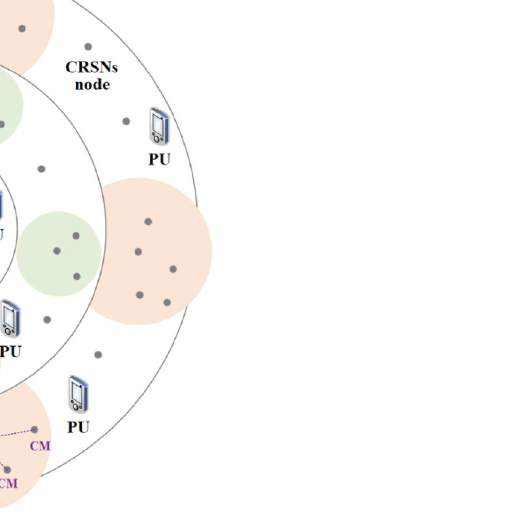
Figure 2. System architecture of cluster-based